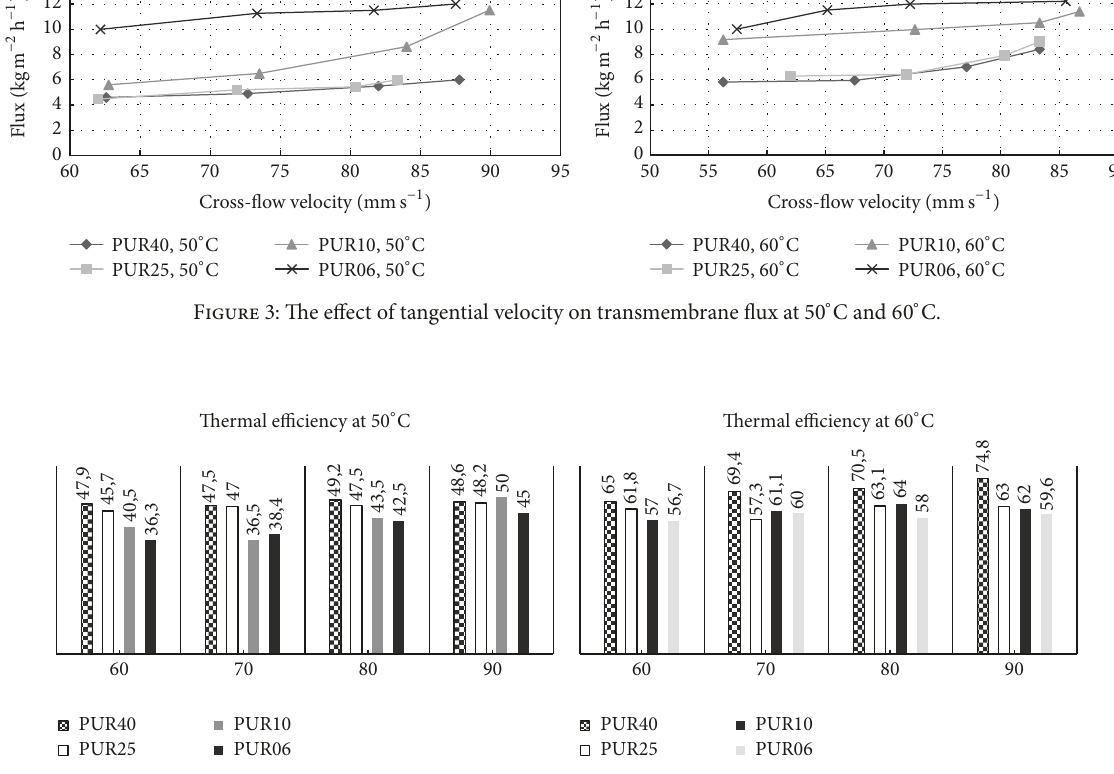
Figure 4: The effect of membrane thickness on process